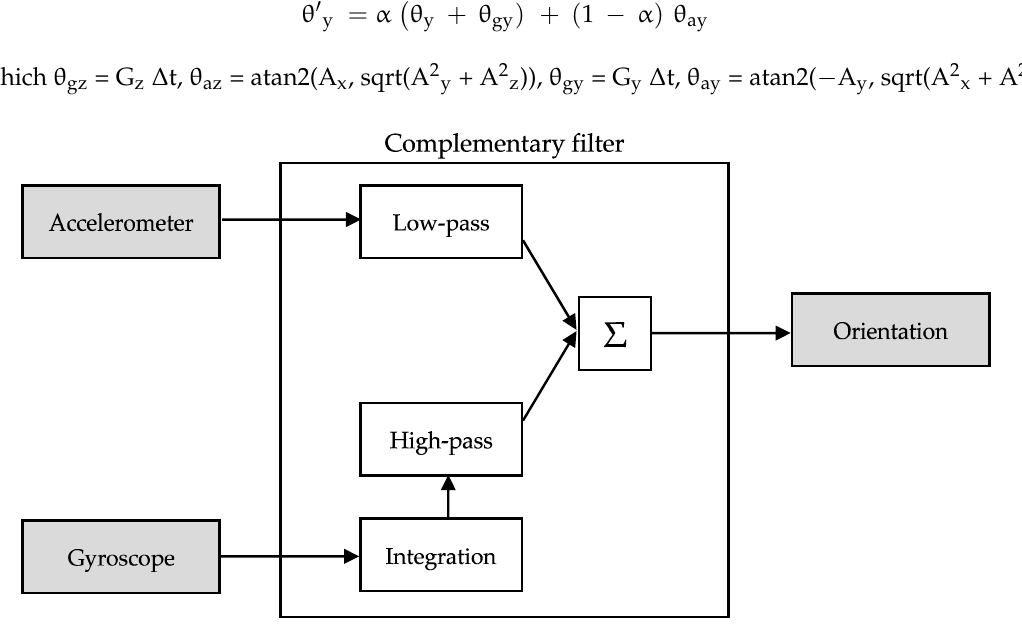
Figure 2. Block diagram of the complementary filter. The complementary filter removes noise (low-pass) from the accelerometer data and eliminates drift (high-pass) of gyroscope data.